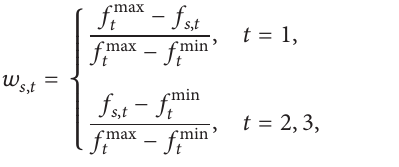
of mutation, and the application of the velocity constriction mechanism of